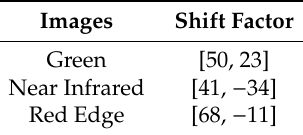
Table 1. Shift factors ( x - and y -direction) used for overlaying the different images using parrot sequoia in shorter distance of plant samples. (Red image used as reference).